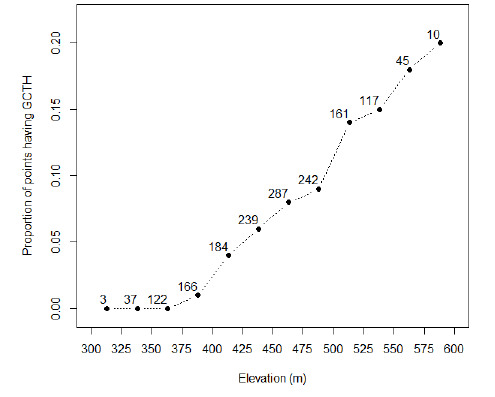
Fig. 5 . Elevational distribution of Gray-cheeked Thrushes (Catharus minimus minimus) in the upper Main River and Humber River watersheds in western Newfoundland, 2006 and 2007. Survey points are grouped by 25-m elevation classes, and the proportion of points where thrushes were observed is plotted at the midpoint of each class. The number of survey points in each elevation class is indicated next to each observation (total =